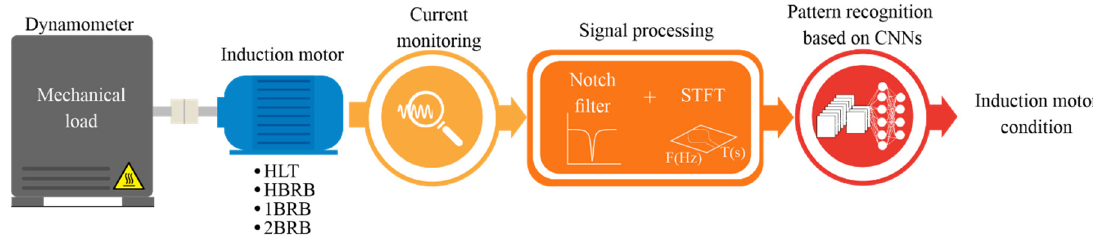
Figure 6. Proposed methodology.